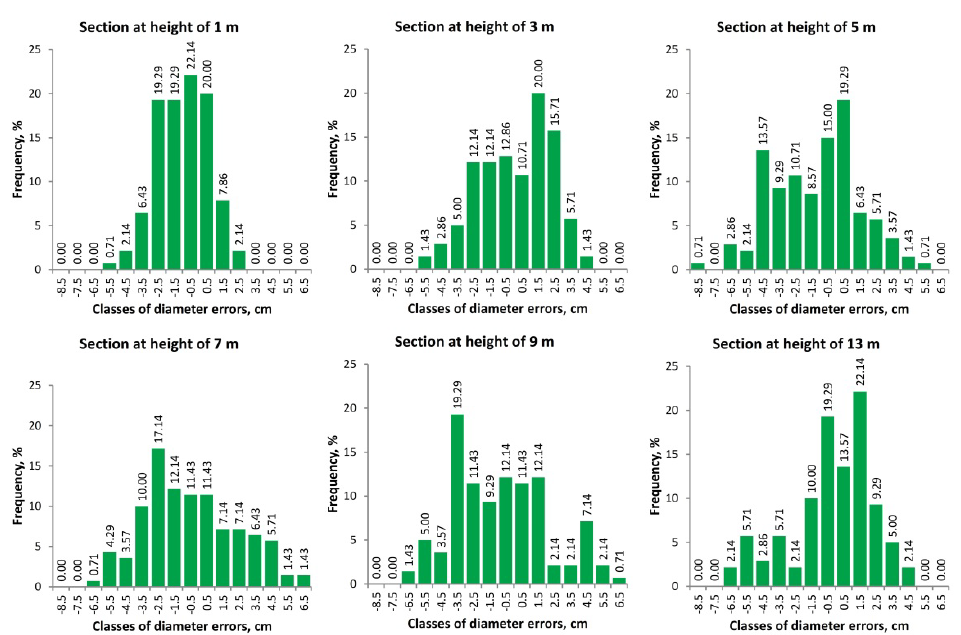
Figure 3. Histograms of errors in stem diameter measurement using a laser caliper for different sections.